Question: Condense the content of this figure into a single sentence.
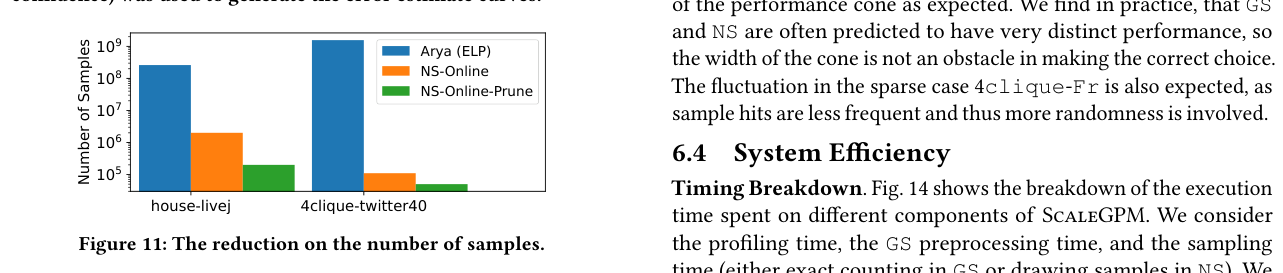
Answer: Predicted errors in our convergence detection mechanism across three different runs (4-clique on Lj) are extremely stable.